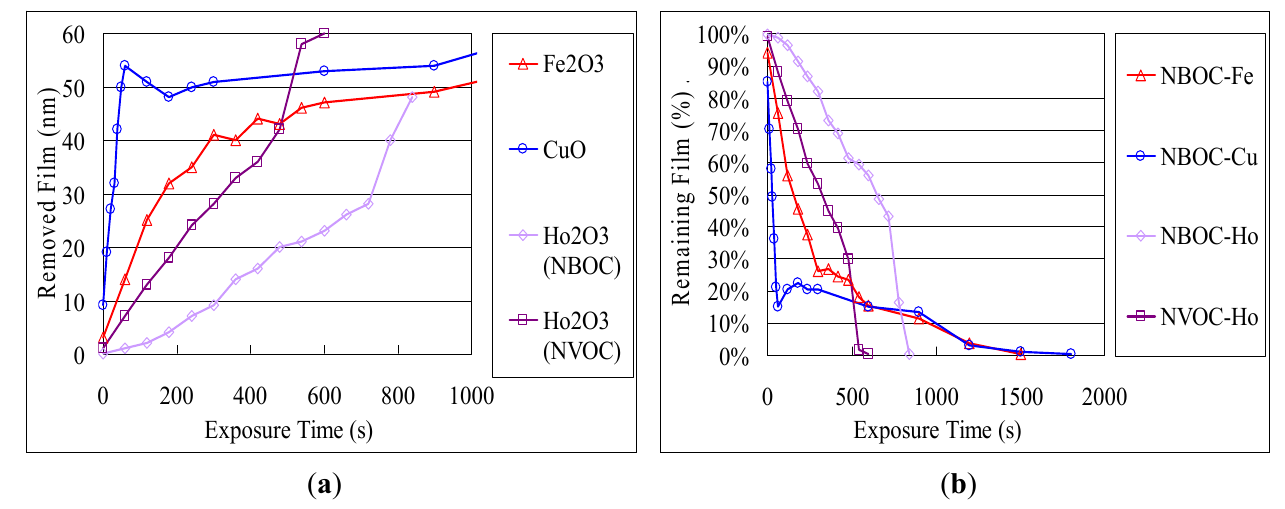
Figure 4. Photo-solvolysis of nitrobenzyl 3,4-dihydroxybenzoate metal complexes in terms of ( a ) the remaining fraction of the total complex film; and ( b ) the amount of removed film in terms of metal oxide